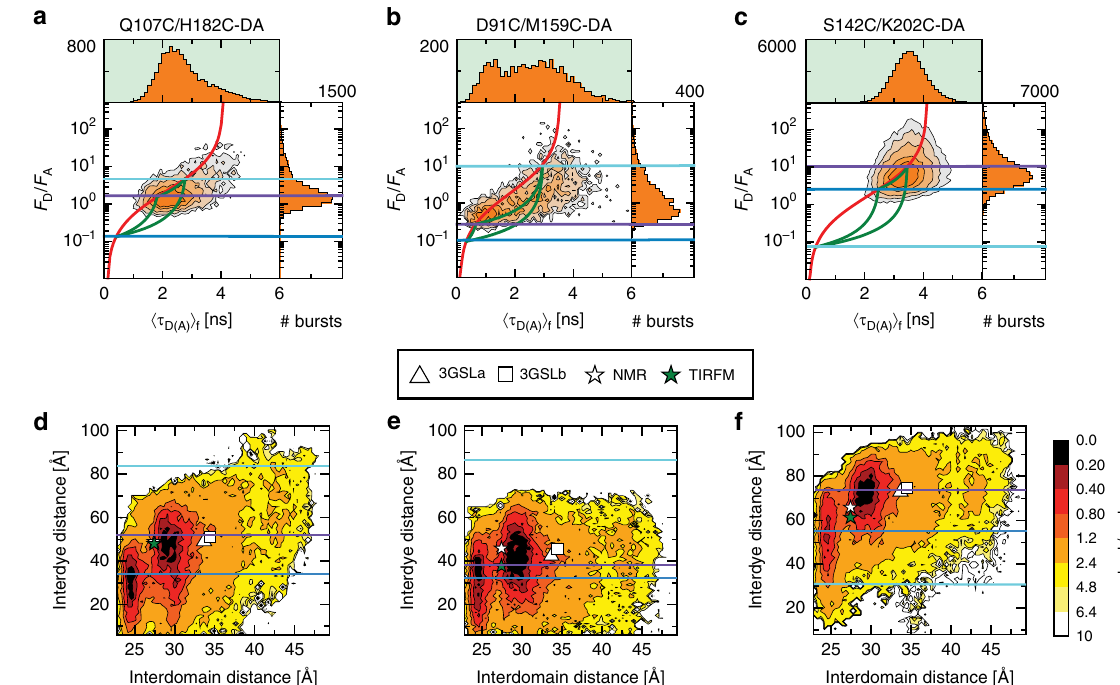
Fig. 3 Multiparameter Fluorescence Detection of FRET and energy landscape of the PDZ1-2 tandem variants. Each panel plots two FRET indicators for each single-molecule event. The donor over acceptor fl uorescence ratio ( F D / F A ) on the y -axis and the average fl uorescence lifetime ( 〈 τ D(A) 〉 f ) on the x -axis. Shown are the 2D histograms (orange contours) for ( a ) Q107C/H182C-DA, ( b ) D91C/M159C-DA, and ( c ) S142C/K202C-DA. The 1D frequency histograms are shown along the axes for each FRET indicator. The static FRET lines (Supplementary Eq. 10, Supplementary Table 3) are shown in red. The dynamic FRET lines (Supplementary Eq. 11, Supplementary Table 4) are shown in green and connect the states identi fi ed with eTCSPC. The mean interdye distances for each of the eTCSPC states was converted to F D / F A and shown as lines colored purple, blue, and cyan in decreasing order of population occupancy. d – f Histograms of the potential mean force (PMF) calculated from DMD simulations for the variants ( d ) Q107C/H182C-DA, ( e ) D91C/M159C- DA, and ( f ) S142C/K202C-DA. The remaining histograms are shown in Supplementary Fig. 6. Histograms show the interdomain distance between the center of mass of the two PDZ domains plotted against the interdye distance distribution, which was calculated as p ( R DA ) PMF = exp( − E PMF / k B T ) where E R k PMF is the integrated free energy over interdomain distance as the function of the interdye distance, DA ; and B is Boltzmann constant. Contours are scaled in kcal/mole. Lines represent the mean interdye distances for each of the states identi fi ed by eTCSPC and are colored purple, blue, and cyan in decreasing order of population occupancy. Interdomain distances for previously reported models of the PDZ tandem are marked by symbols and denoted beneath the panels. Two basins are clearly identi fi ed, with residual states that are heterogeneously distributed with respect to the interdomain